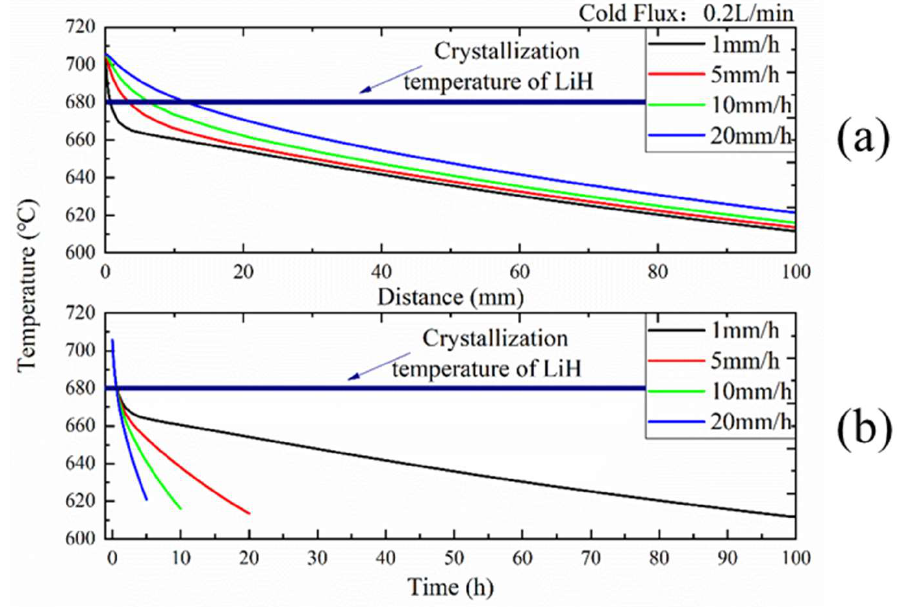
Figure 12. The temperature variation at the LiH conical point at different rise speed. (a) is for the upward distance of furnace and (b ) is for the time furnace moved.